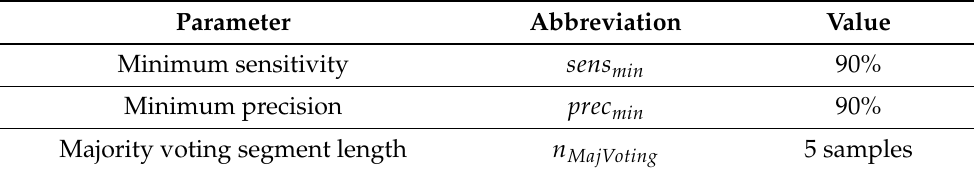
Table 1. Hyperparameters for the adaptive